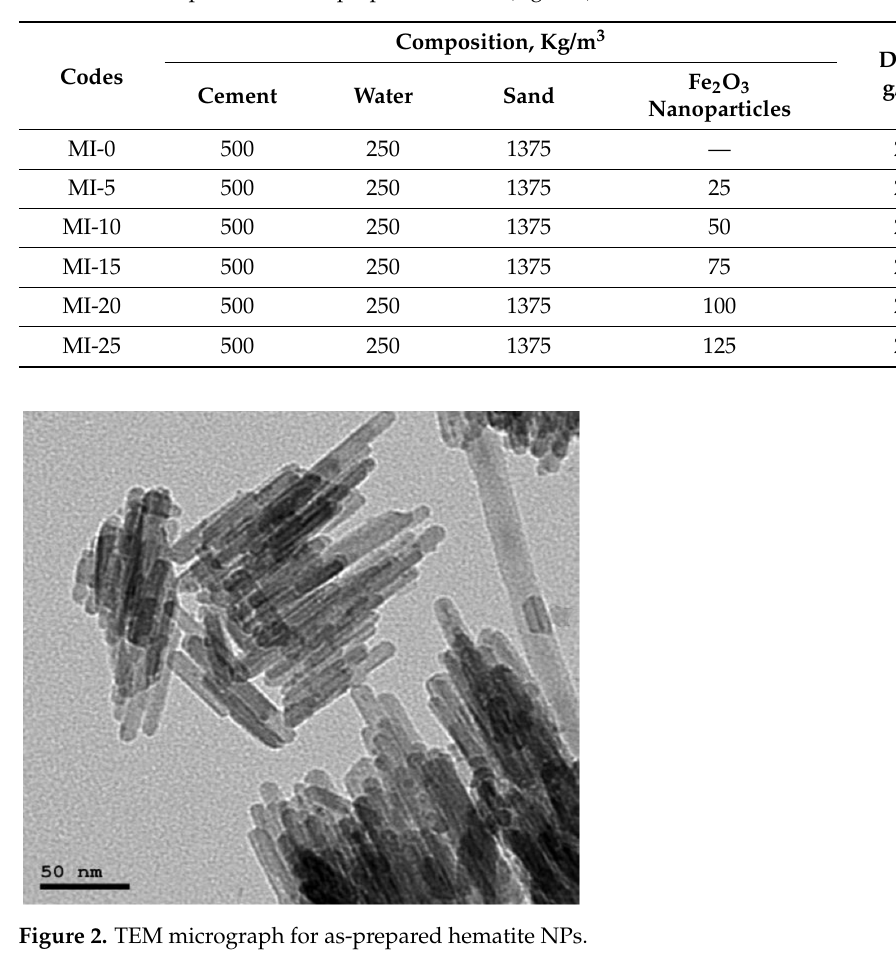
Table 1. The composition of the prepared mortar (Kg/m 3 ).